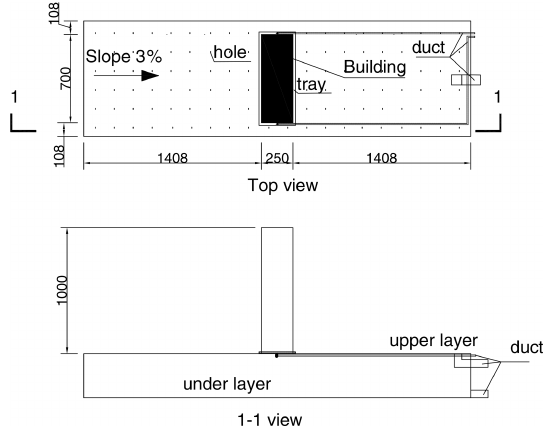
Figure 3. The size of the scale